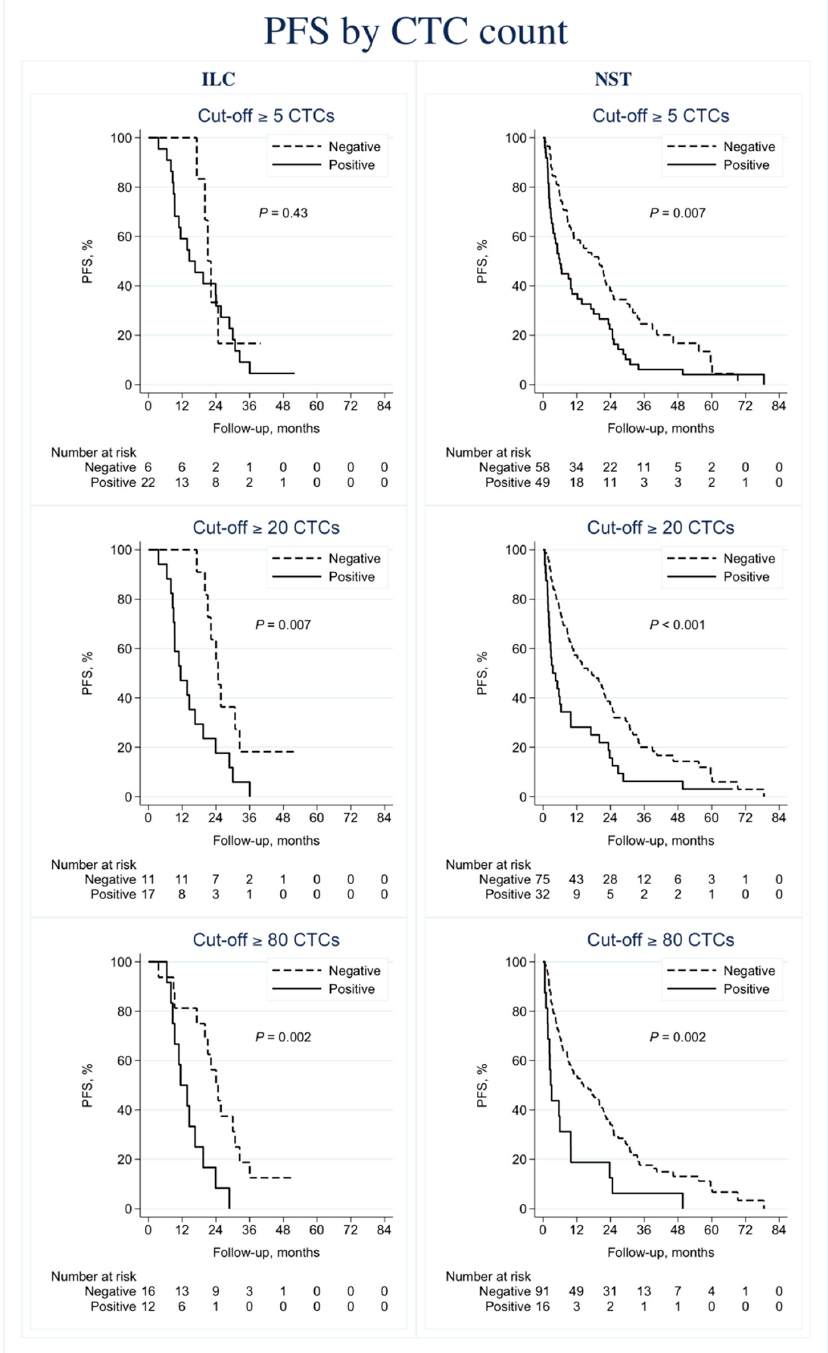
Figure 4. Progression-free survival (PFS) by circulating tumor cell (CTC) count. Kaplan–Meier plots displaying PFS for the invasive lobular carcinoma (ILC) and invasive ductal carcinoma of no special type (NST) subgroups. Cut-off ≥ 5 CTCs ( A – B ). Cut-off ≥ 20 CTCs ( C – D ). Cut-off ≥ 80 CTCs ( E – F ).